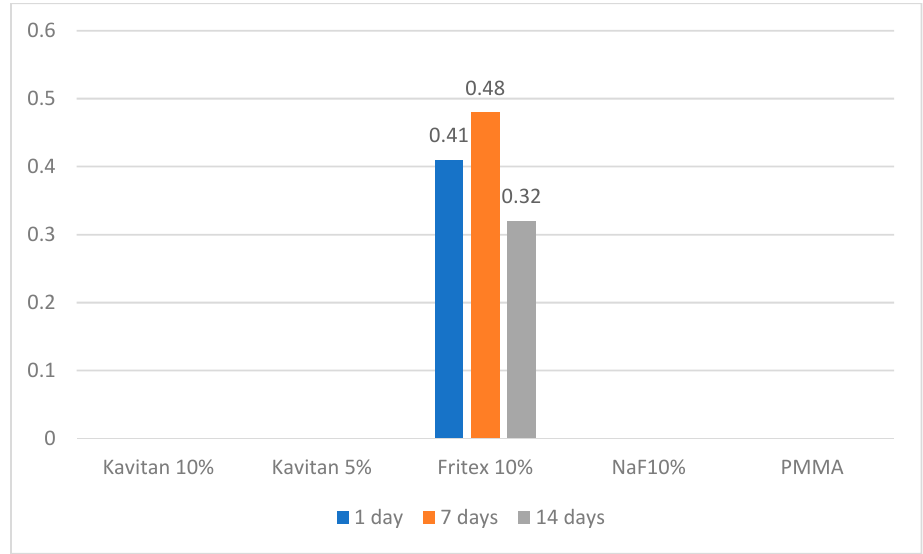
Figure 3. Amount of fluoride released after contact with the 1450 ppm fluoride toothpaste. Table 3. Mean values ± SD of fluoride release [µg/cm 2 ]. Sorption values ranged from 10.23 µ m/mm 3 for unmodified PMMA resin to 12.11 µ m/mm 3 for specimens modified with 10 wt% Kavitan glass. Materials modified with 10 wt% NaF as well as modified with 10 wt% Kavitan had higher sorption levels after 7 days 11.95 ± 0.33 µ m/mm 3 and 12.11 ± 0.8 µ m/mm 3 than the other tested ma-